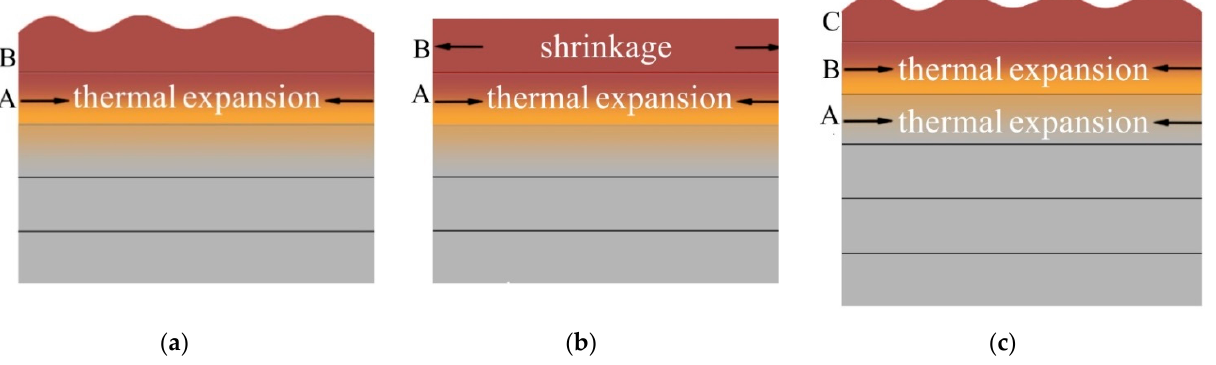
Figure 12. Schematic representation of the mechanism of residual stress generation in an EBAM sample during molten pool formation ( a ), shrinkage of the new build layer ( b ), and building of the next layer ( c ).